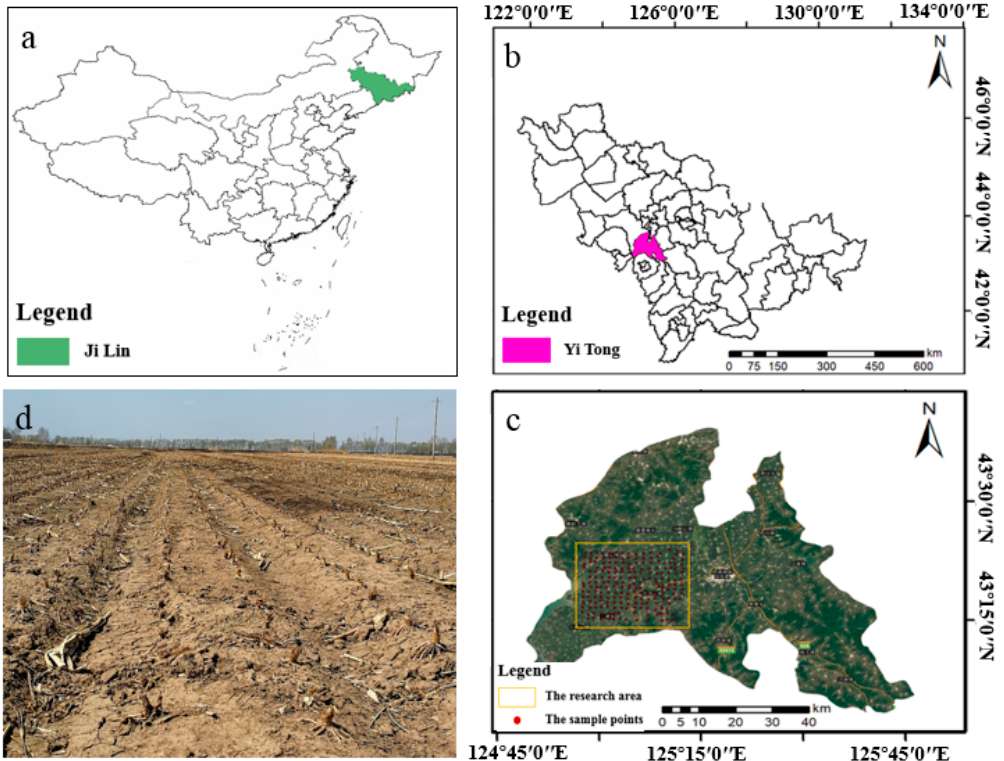
Figure 1. Maps of the study area ( a : a map of China; b : a map of Ji Lin Province; c : The research area and sampling points distribution; d : landscape photograph by M.F. Gao).